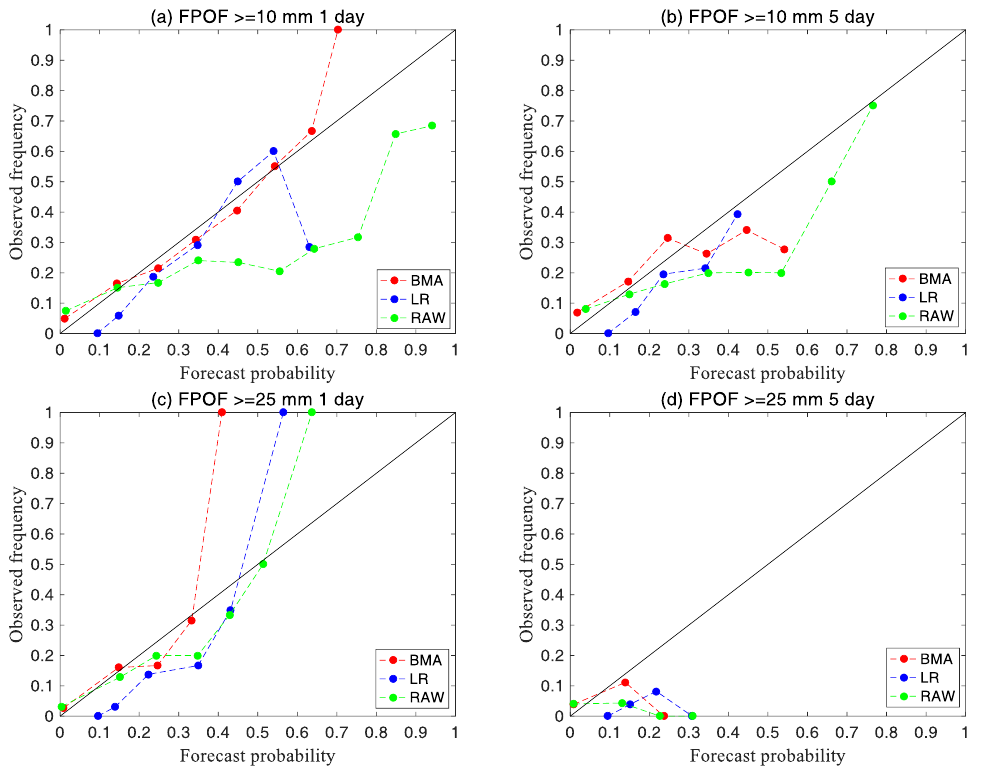
Figure 4. The reliability diagram for daily precipitation ≥ 10 mm ( a , b ) and ≥ 25 mm ( c , d ), probability forecasts of BMA, LR, and RAW with lead times of 1 day and 5 days.